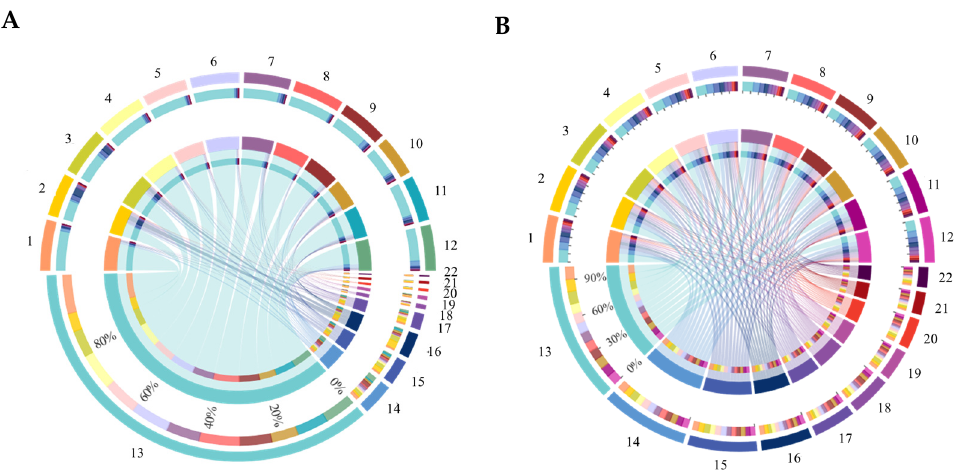
Figure 6. Community compositions of bacterial ( A ) and fungal ( B ) classes in soil of different treatments. For figure ( A ), numbers represent: 1. CK1, 2. CK2, 3. CK3, 4. B1, 5. B2 6. B3, 7. O1, 8. O2, 9. O3, 10. W1, 11. W2, 12. W 3, 13. Alphaproteobacteria, 14. Gammaproteobacteria, 15. Gemmatimonadetes, 16. Phycisphaerae, 17. Planctomycetacia, 18. Verrucomicrobiae, 19. Actinobacteria, 20. Subgroup_6, 21. Blastocatellia_Subgroup_4, and 22. Bacteroidia. For figure ( B ), numbers represent: 1. CK1, 2. CK2, 3. CK3, 4. B1, 5. B2 6. B3, 7. O1, 8. O2, 9. O3, 10. W1, 11. W2, 12. W3, 13. Sordariomycetes, 14. Dothideomycetes, 15. Eurotiomycetes, 16. Leotiomycetes, 17. Agaricomycetes, 18. Pezizomycetes,